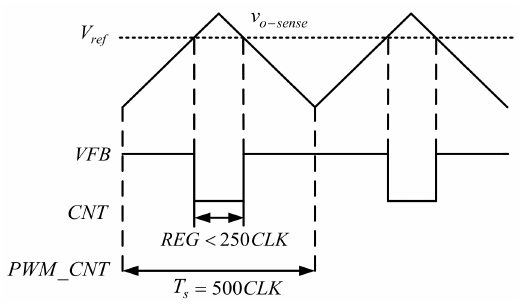
Figure 10. Average value of v o-sense less than the value of V ref .